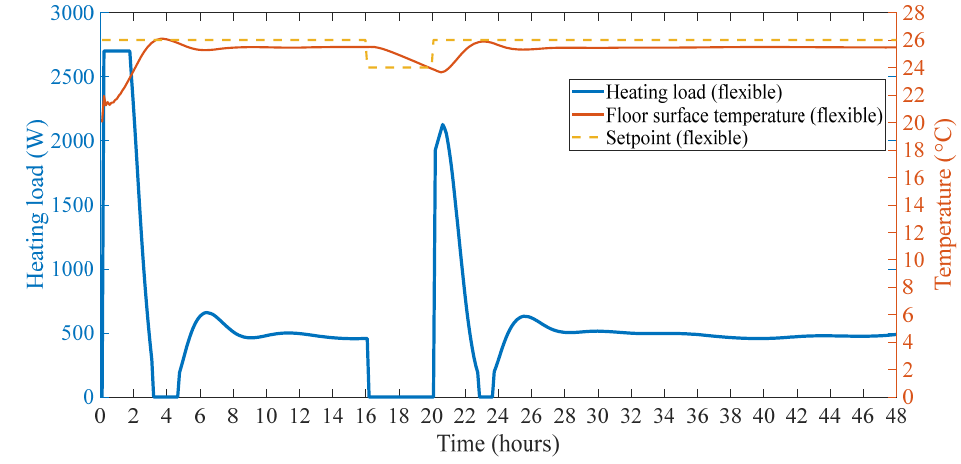
Figure 8. Downward flexible case for floor surface temperature control.